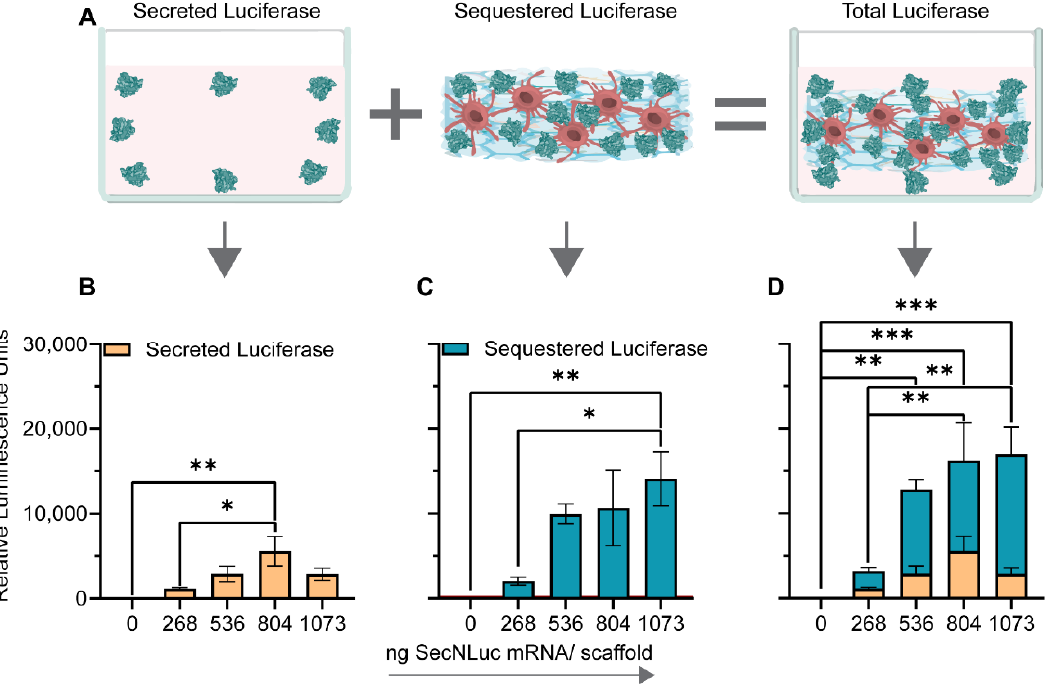
Figure 4. Dose–response function of C2C12 cells seeded on 3D collagen scaffolds functionalized with PF14-formulated secreted nanoluciferase mRNA nanoparticles. ( A ) Schematic of the experimental detection strategy. Secreted nanoluciferase was detected 24 h post-transfection, followed by collagenase digestion of the scaffold for 24 h, in which the amount of sequestered nanoluciferase was determined. ( B ) Quantification of secreted and ( C ) sequestered nanoluciferase. ( D ) Merged quantification of secreted and sequestered nanoluciferase by chemiluminescence. Data represent the mean + SEM of two independent experiments. *: p ≤ 0.05, **: p ≤ 0.01, ***: p ≤ 0.001.